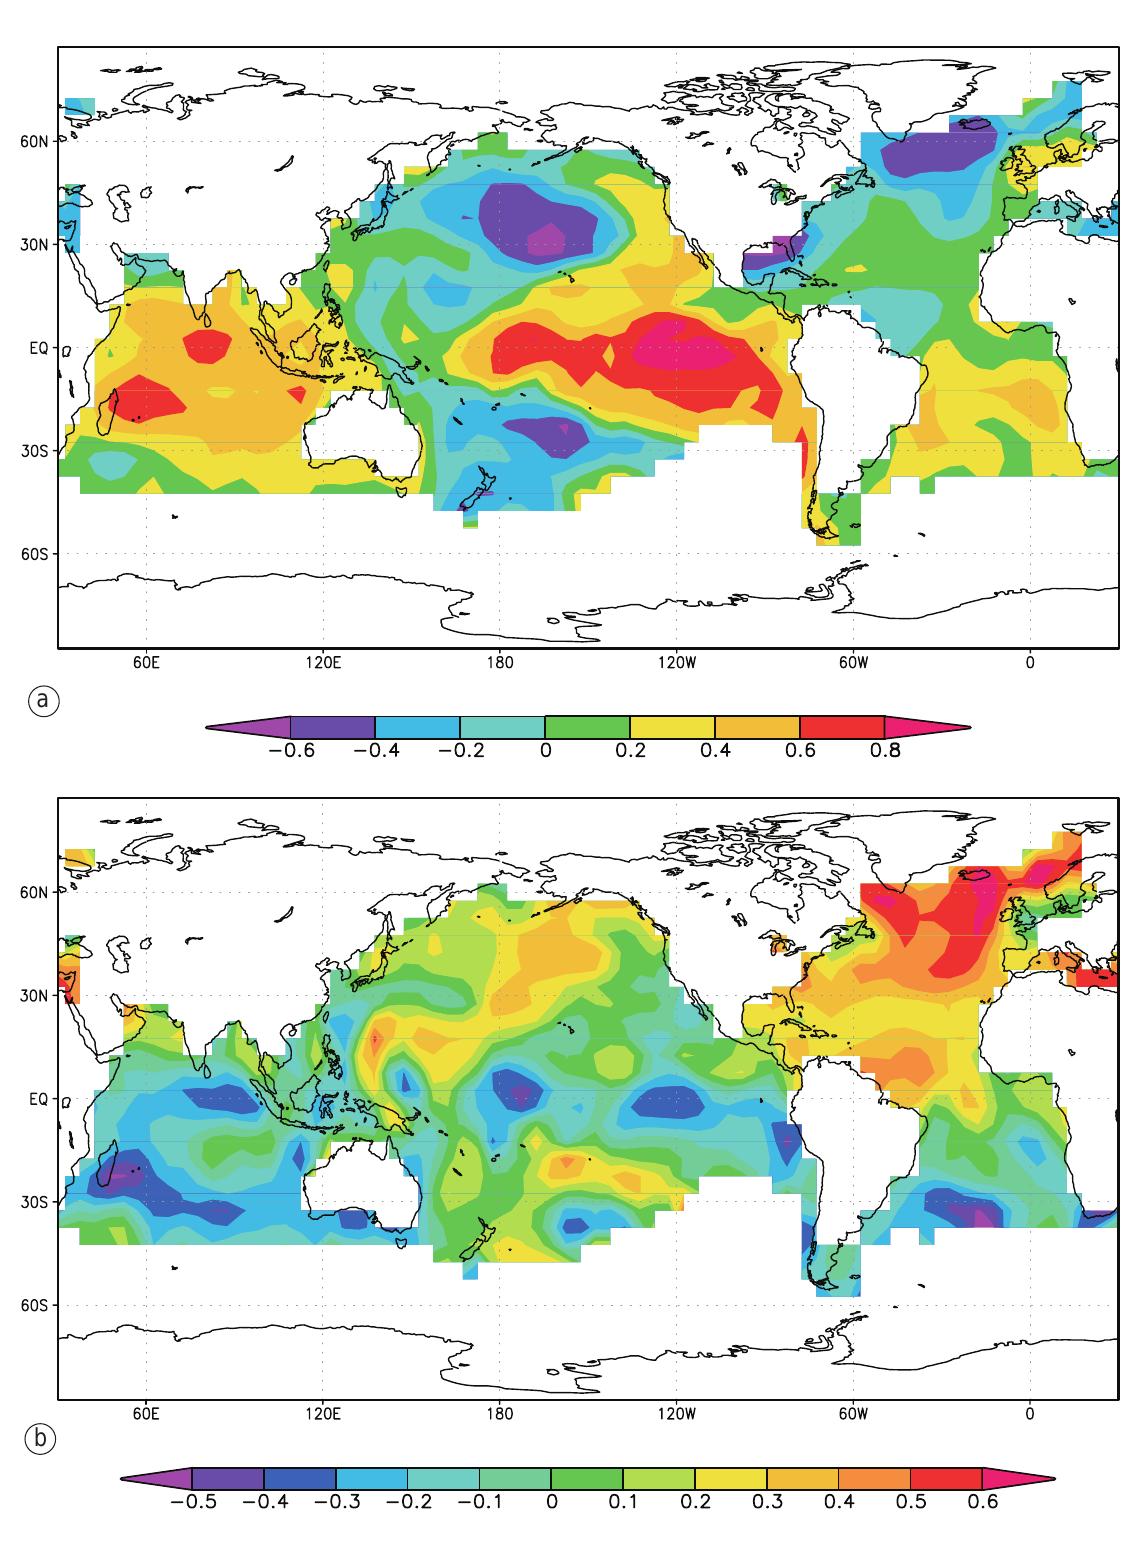
Fig. 7a,b. a) Spatial distribution of correlation coefficients between the Niño-3 SST anomaly time series and the global SST anomalies at zero lag. b) Spatial distribution of correlation coefficients between the Niño-3 SST anomaly time series and the global SST anomalies at lag 30 years. The anomaly structure in (b) is reminiscent of variations in the THC, indicating that variations in the THC follow variations in tropical Pacific SST with a time lag of 30 years. The data were low-pass filtered with a 11-year running mean prior to the correlation analyses.